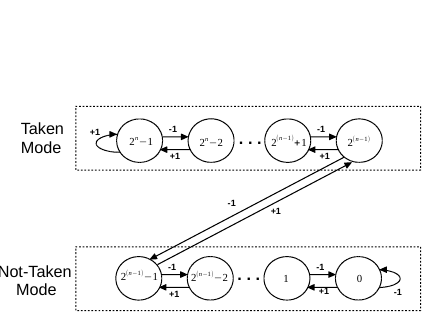
Figure 2: The finite state machine of an n -bit saturating counter. When this counter is in the taken mode, its predic- tion output will be taken, and vice